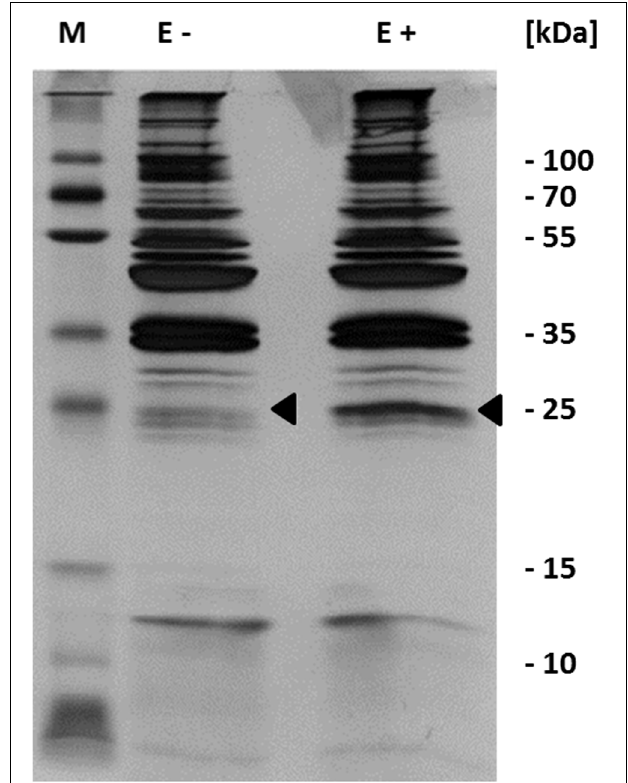
FIGURE 3 | Identification of c-di-AMP binding proteins. Detection of in vitro c-di-AMP binding was performed with c-di-AMP immobilized to an agarose matrix. This was incubated with cell extract from M. pneumoniae . The c-di-AMP bound proteins were eluted with free c-di-AMP and analyzed by SDS-polyacrylamide gel electrophoresis and visualized by silver staining. Proteins were identified by mass spectrometry. Arrows show mass spectrometry analyzed bands. E, elution fraction; +, agarose coupled with c-di-AMP; − , agarose coupled with